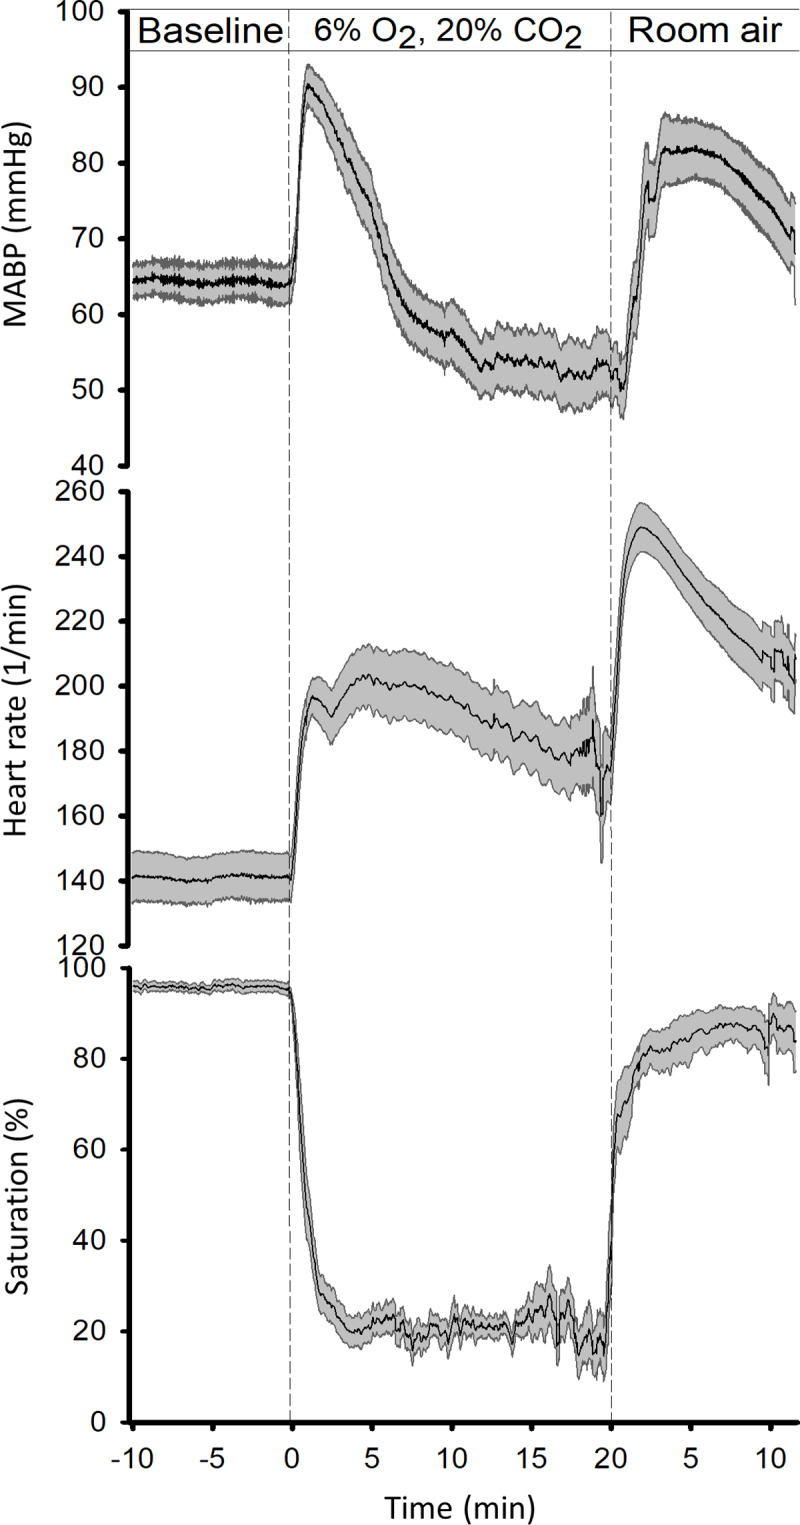
Hemodynamic and oxygenation changes during PA.In all panels, solid lines indicate the mean and the grey shaded area the SEM. (n = 13). After obtaining baselines, PA was initiated resulting first in the transient elevation of mean arterial blood pressure (MABP, top panel) and heart rate (HR, middle panel) accompanying the rapid fall in blood oxygen saturation (pulsoxymetry, bottom panel). While blood oxygen saturation remained ~20% throughout the asphyxia, after the initial peak, MABP fell continuously below baseline, whereas the drop in HR was more moderate and HR remained elevated. Reventilation with air quickly restored oxygen saturation and induced a second transient elevation in both MABP and HR.